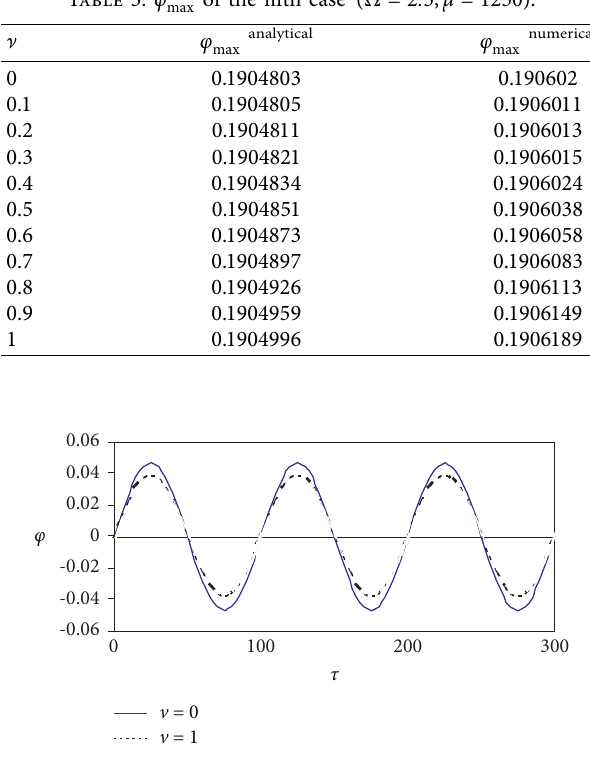
Figure 12: The analytical solutions for case (v) in Section